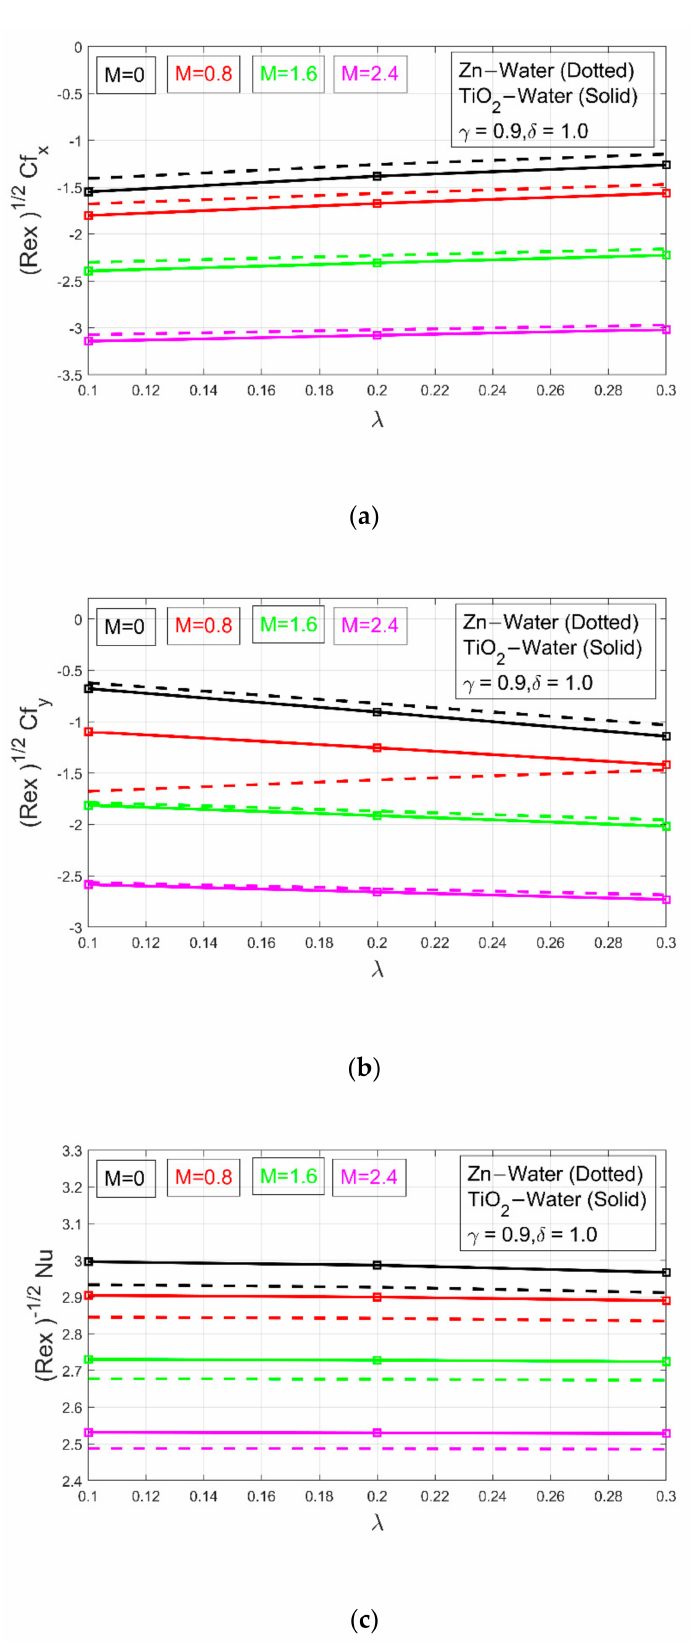
Figure 6. ( a ) Skin friction along the x -axis, ( b ) skin friction along the y -axis, and ( c ) Nusselt